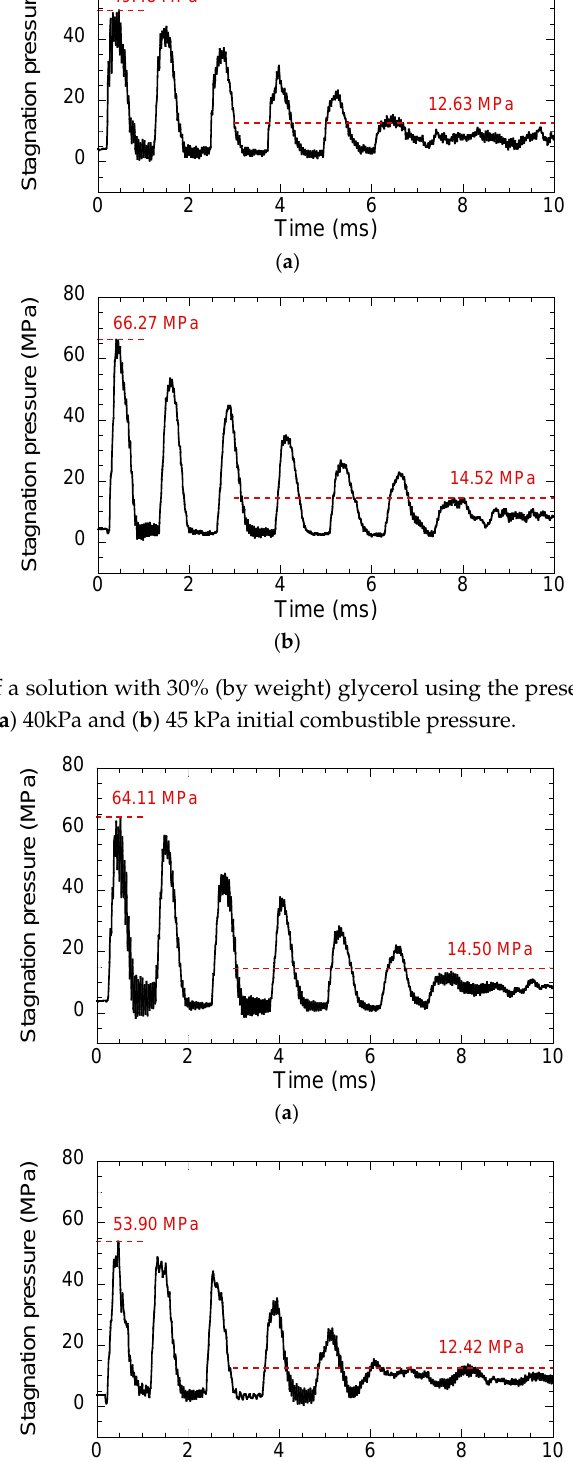
Figure 10. Injection of a solution with ( a ) 50% (by weight) and ( b ) 70% glycerol using the present detonation-driven injector device with an initial combustible pressure of 45 kPa.